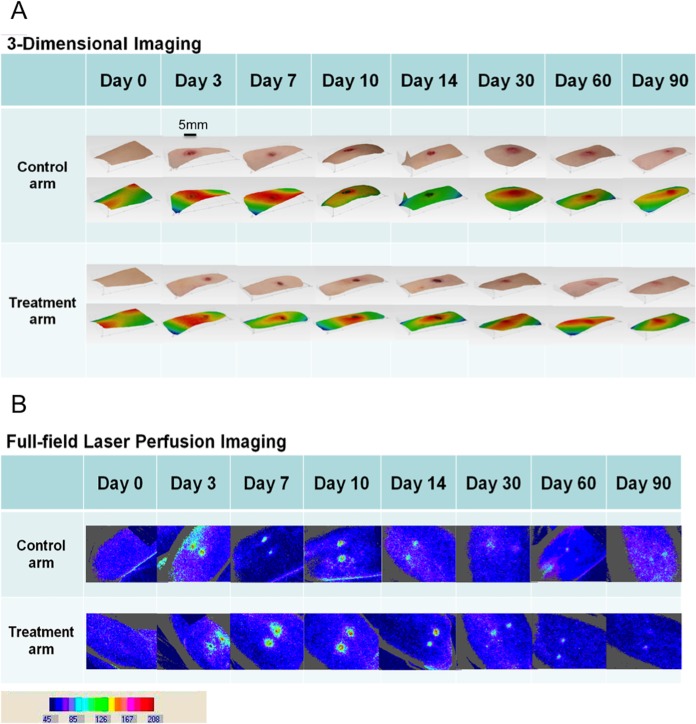
Images produced from the non-invasive imaging devices.A. Images from the 3-dimensional camera are shown which demonstrate the size of the biopsy wound sites are smaller post electrical stimulation (ES) compared to the control. The normal wound image is displayed with the difference in heights images corresponding shown below. The difference in heights images show the highest points are indicated in red and yellow, whilst the lowest points are displayed as green and blue. B. Images from the full-field laser perfusion imager at each time point demonstrating the blood flow for the control and post-ES arm. The differences in blood flow (flux) in the biopsy sites are depicted by the change of colour intensity in the images.